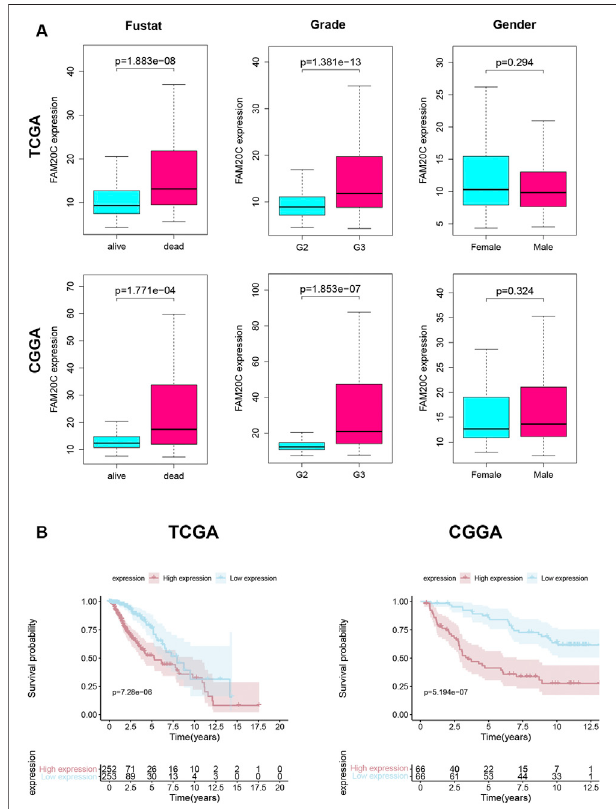
FIGURE 2 | Association with FAM20C expression and clinicopathological characteristics. (A) Clinical in TCGA database, including grade (grade 2 n (cid:1) 248, and grade 3 n (cid:1) 261); fustat (alive n (cid:1) 400, and dead n (cid:1) 109); gender (male n (cid:1) 281, and female n (cid:1) 228); Clinical in CGGA database,includinggrade(grade2 n (cid:1) 87,andgrade3 n (cid:1) 45);fustat(alive n (cid:1) 68, and dead n (cid:1) 64); gender (male n (cid:1) 81, and female n (cid:1) 51); TCGA, The Cancer Genome Atlas. CGGA, Chinese Glioma Genome Atlas. (B) Kaplan – Meier curves for OS in LGG Higher FAM20C expression was remarkably associated with poorer OS in TCGA database; Higher FAM20C expression was remarkably associated with poorer OS in CGGA database. OS, overall survival. The fustat means the patients ’ survival